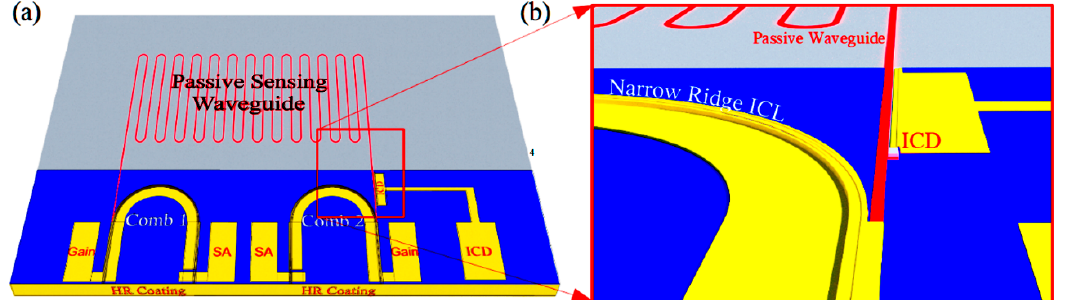
Figure 12. ( a ) On-chip dual-comb spectrometer, in which both facets of both frequency comb ICLs terminate at the same HR-coated facet. Lateral output from the first comb couples to an extended passive sensing waveguide before input to the ICD, while output from the local oscillator comb transfers directly to the same ICD; ( b ) detail showing both inputs coupling evanescently to opposite ends of the ICD.